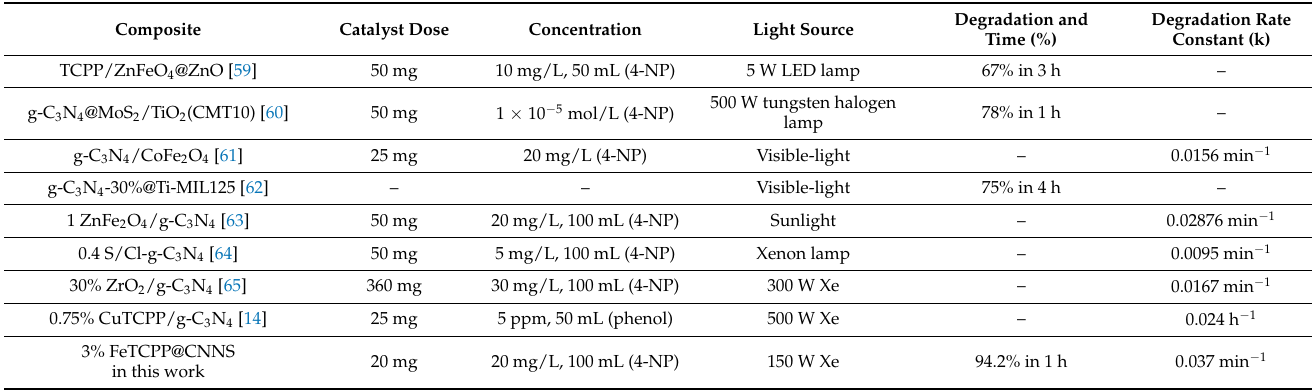
Table 2. Some reported materials based on g-C 3 N 4 or TCPP studied for photocatalysis under visible light irradiation in recent years.